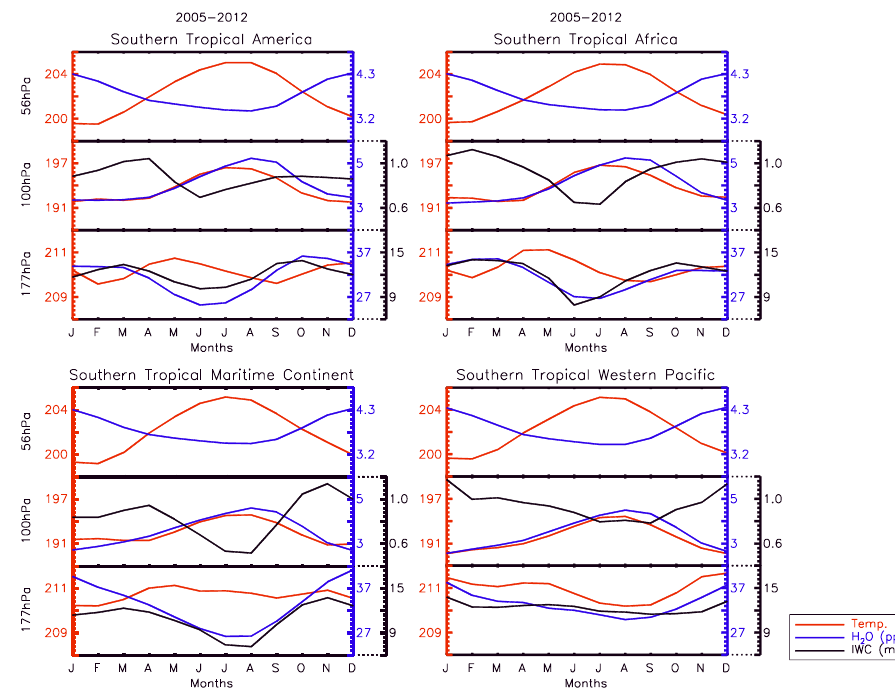
Figure 9. MLS 2-month running average, from 2005 to 2012, H 2 O (blue line), temperature (red line) and IWC (black line) from January to December at 56 (top), 100 (middle) and 177hPa (bottom) in southern tropical America (top left) and southern tropical Africa (top right), the southern tropical maritime continent (bottom left) and southern tropical western Pacific (bottom right).